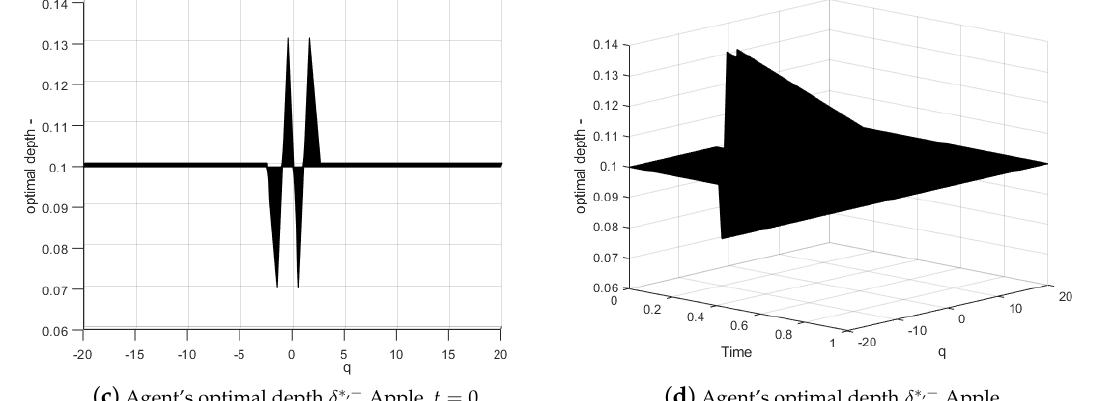
Figure 8. Agent’s optimal depth for selling LOs and Agent’s optimal depth for buying LOs for Apple stocks. ( a ) the agent’s optimal depth calculated with Equation (94), using the parameters in Table 8 at time zero. ( b ) the agent’s optimal depth calculated with Equation (94), using the parameters in Table 8 in 3 dimensions. ( c ) the agent’s optimal depth calculated with Equation (95), using the parameters in Table 8 at time zero. ( d ) the agent’s optimal depth calculated with Equation (95), using the parameters in Table 8 in 3